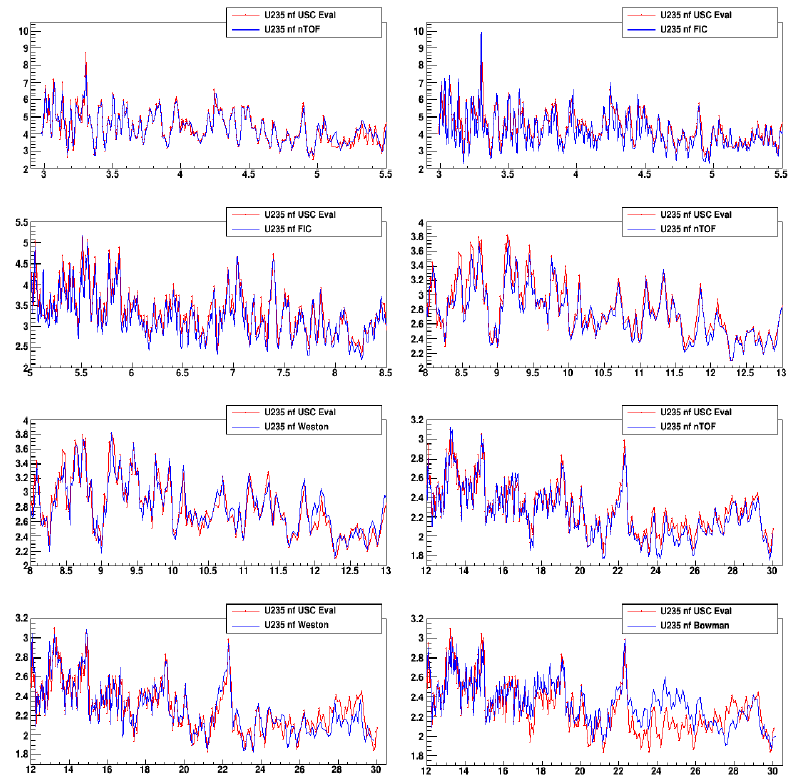
Fig. 3. Comparison of the USC-Eval with experimental datasets at different energy